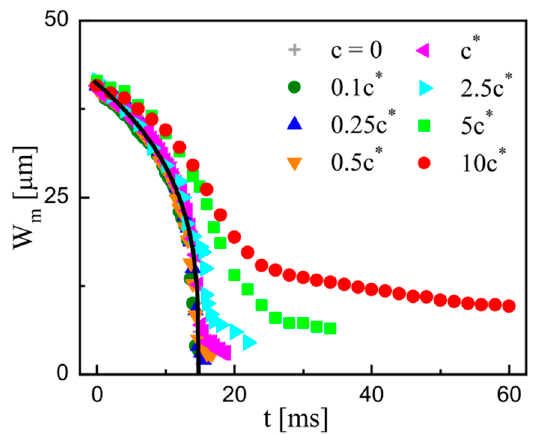
Figure 4. Time evolution of the minimum filament width W m at different PEO concentrations. The black solid curve W m ~ (14.8 − t ) 0.32 is the fit for the Newtonian case, i.e., c = 0. The flow conditions are identical.